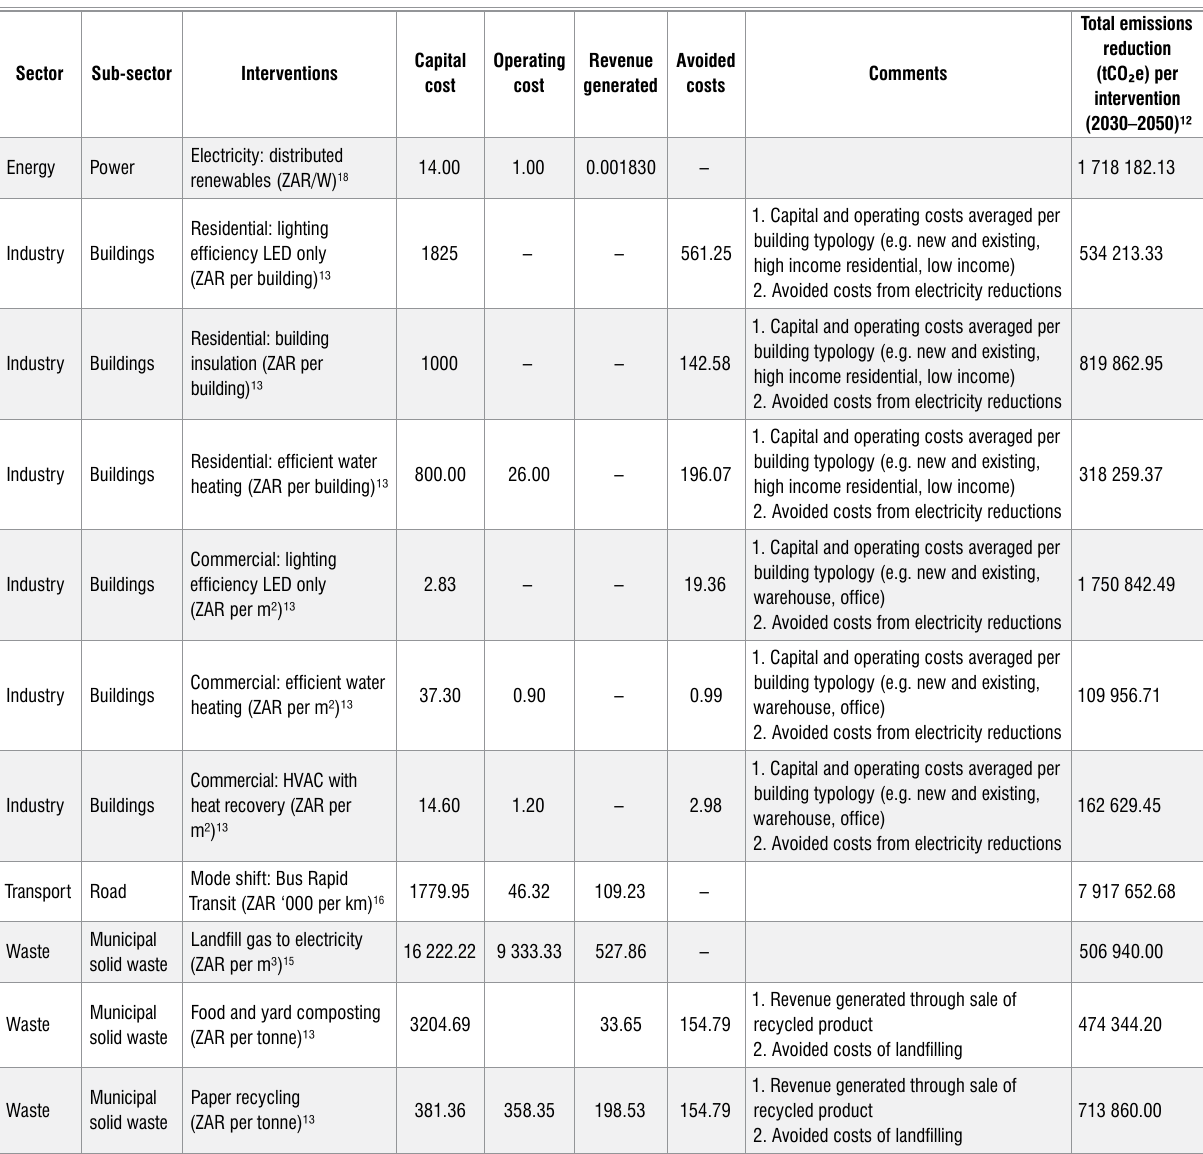
Summary of input data costs per intervention, noting references to the sources of the input